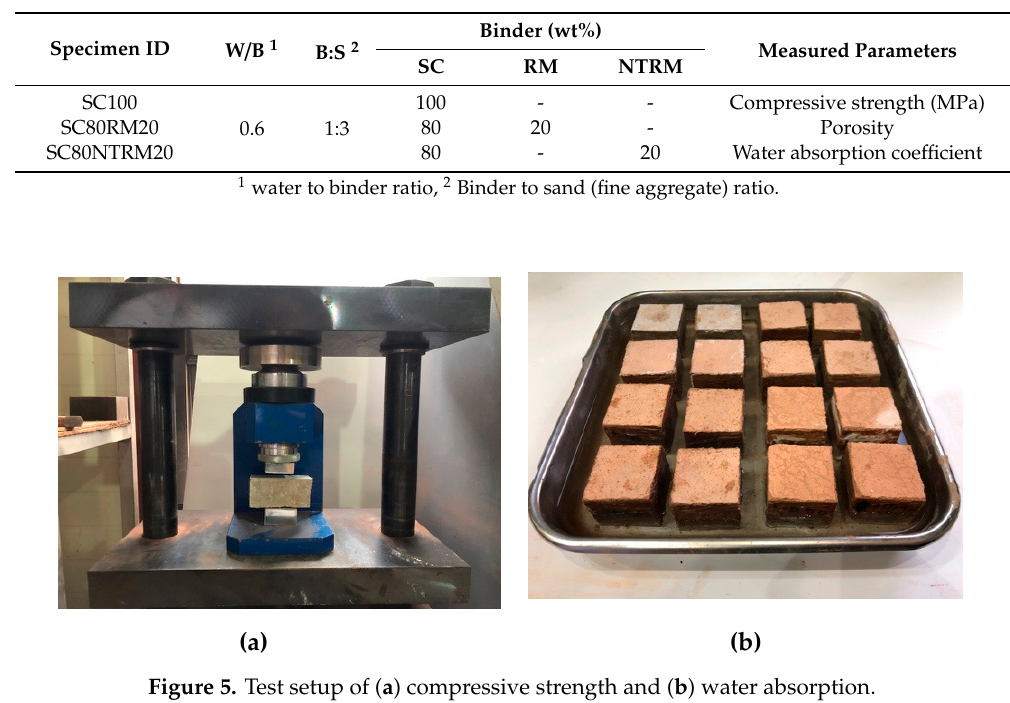
Table 4. Experimental plan and mixture proportion of mortar.